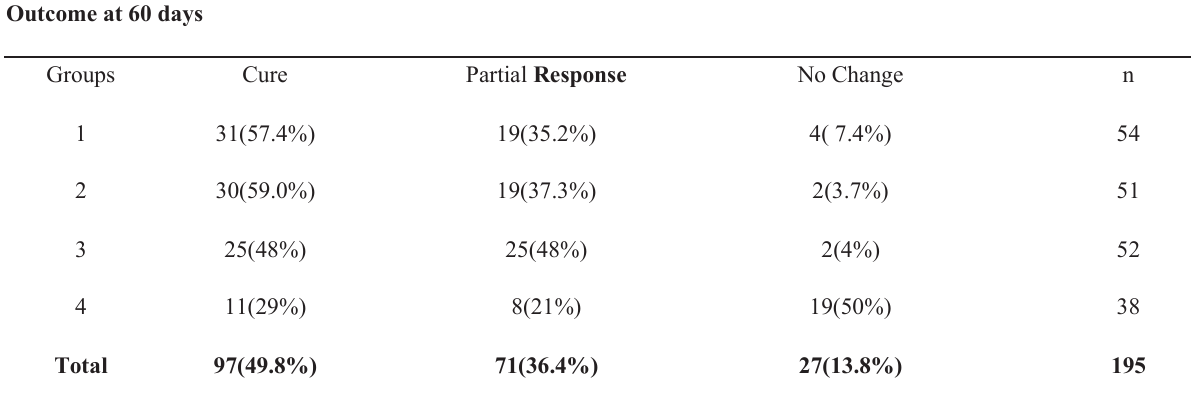
Table 3 - Outcome after 60 days according to treatment Groups (number of patients and percentage).